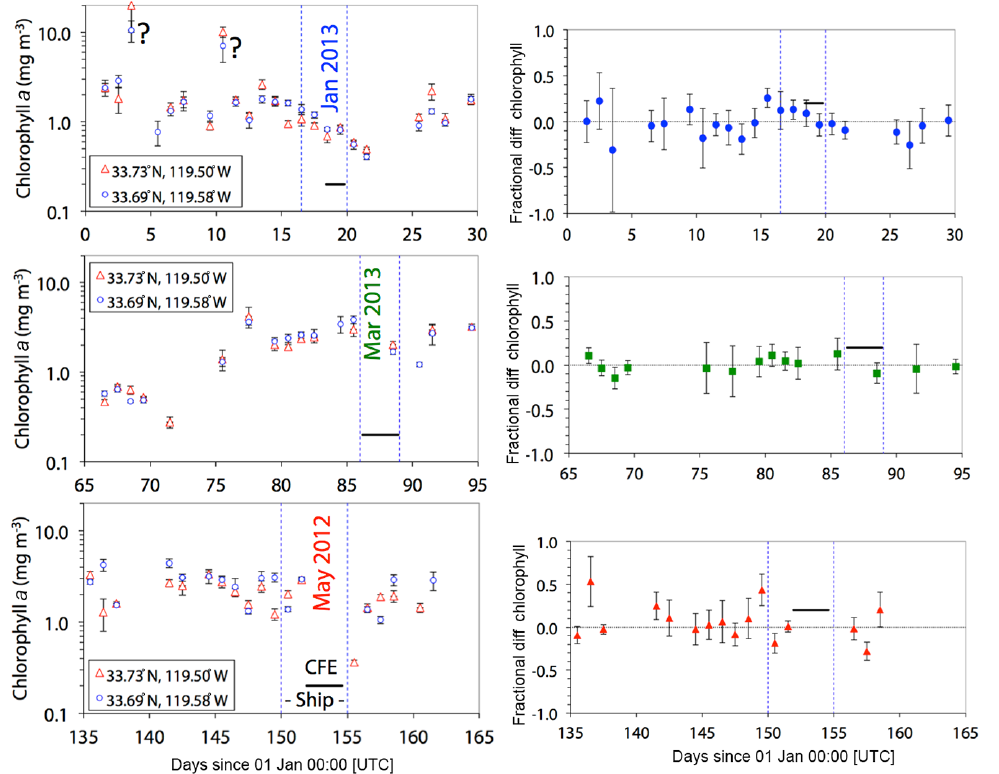
Figure A3. Left panels: means and standard deviations of chlorophyll a retrieved from 1km spatially resolved merged MODIS Aqua and Terra and VIIRS Sumoi products within 2km radius of 33.73 ◦ N, 119.50 ◦ W (red triangles) and 33.69 ◦ N, 119.58 ◦ W (blue circles). Top to bottom: graphs correspond to times of sampling. The 1km results are raw merged products. The data indicated by “?” are incongruent with the rest of the time series. Dashed blue lines denote the periods that the ship was on station in the Santa Cruz Basin study area. The black horizontal line denotes duration of CFE deployments. Right panels show the fractional difference in mean chlorophyll between the two locations. There was no systematic difference between